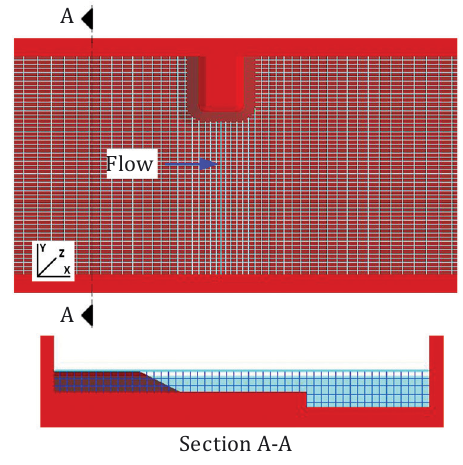
Figure 4. Computational grid: 2D mesh and cross-section for Morales & Ettema (2013) laboratory model